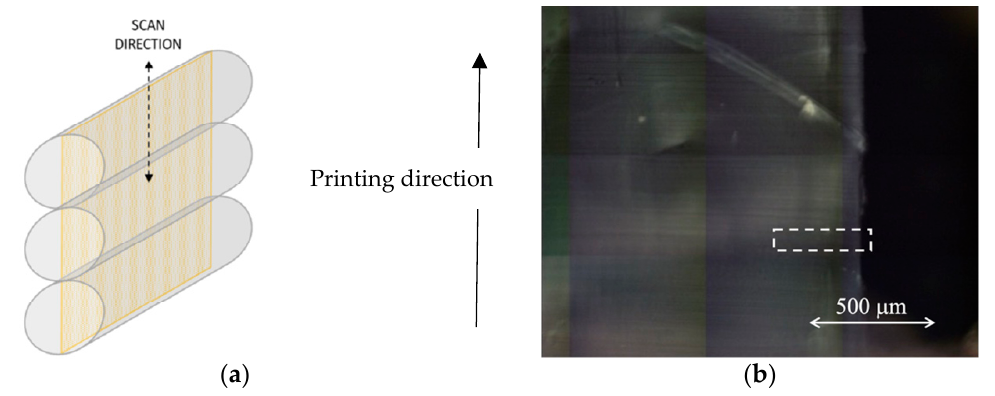
Figure 5. ( a ) Sketch of the microtoming operation that was adopted for preparing the samples for the PM-IR measurements; ( b ) an example of a PLA_4_200k sample printed at 20 mm/s and 210 °C to be scanned with PM-IR. The X-Y axis represents relative distance in microns on the microscope sample stage.